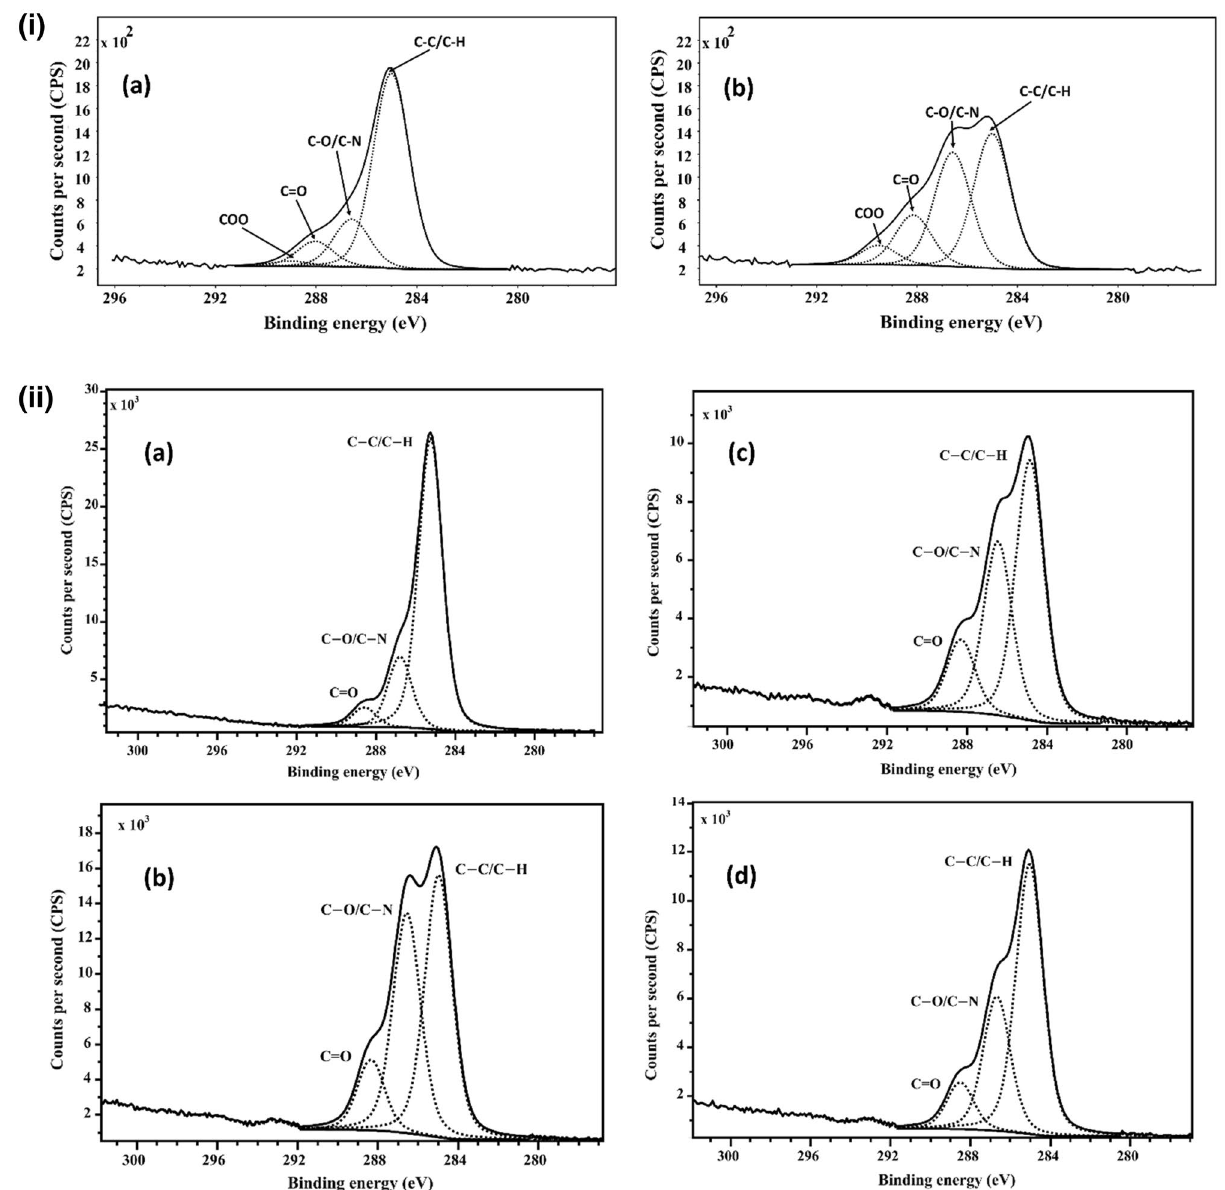
Figure 5. ( i ) Component fitting of high-resolution C1s spectra of ( a ) untreated and ( b ) water plasma-treated Bambara seeds. Bambara seeds were exposed to water plasma for 10 s at a discharge power of 10 W. ( ii ) Component fitting of high-resolution C1s spectra for untreated, oxygen plasma-treated chilli seeds on days 4, 21 and 51 is illustrated in sub-figures ( a – d ), respectively. Chilli seeds were exposed to oxygen plasma for 60 s at a discharge power of 80 W. To investigate the ageing behaviour, the XPS was carried out on the above-mentioned days. ( iii ) Component fitting of high-resolution C1s spectra for untreated, oxygen plasma-treated papaya seeds on days 4, 21 and 51 is illustrated in sub-figures ( a – d ), respectively. Papaya seeds were exposed to oxygen plasma for 40 s at a discharge power of 80 W. to investigate the ageing behaviour, the XPS was carried out on the above- mentioned